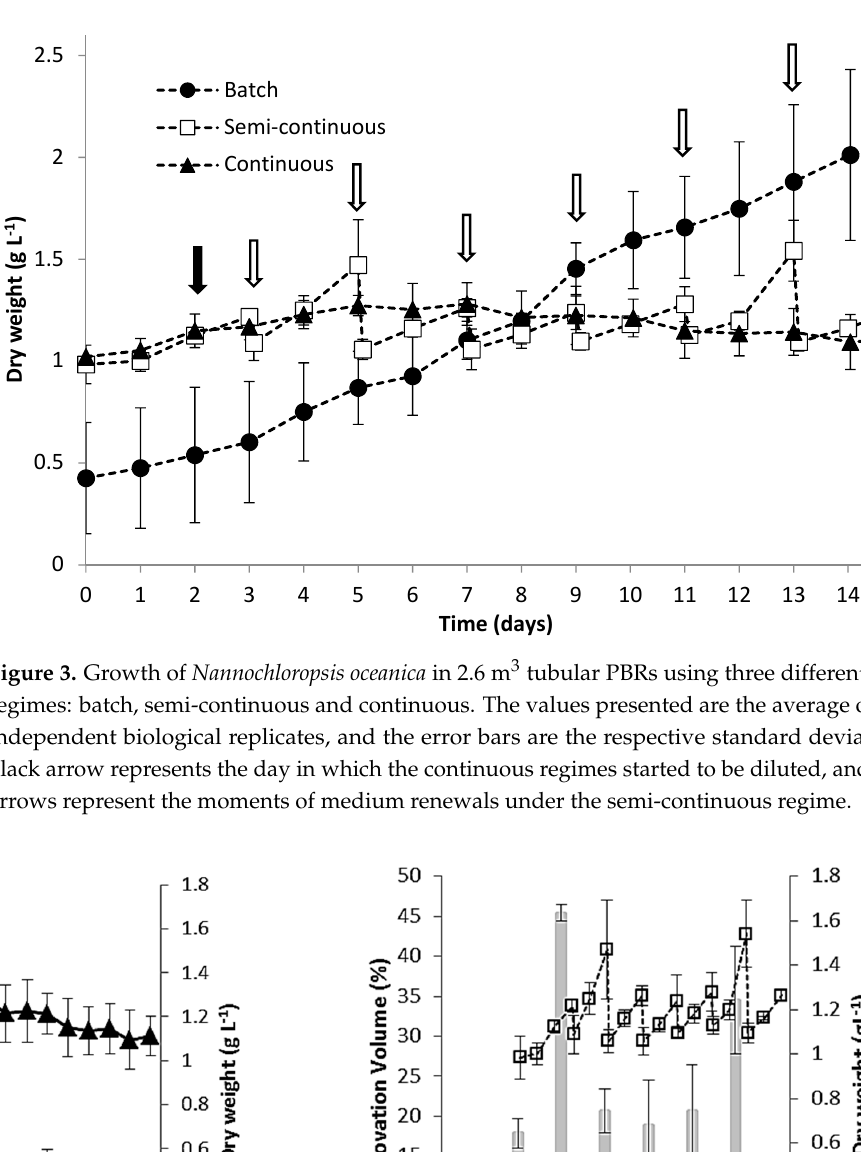
Table 1. Specific growth rate, average dilution rate and amount of water spent, either per cycle or per amount of produced biomass, in the growth of Nannochloropsis oceanica in 2.6 m 3 tubular PBRs, in three different operation regimes. The values represent the average and standard deviation of three biologically independent replicates. Different letters within the same column represent significantly different values ( p -value < 0.05).